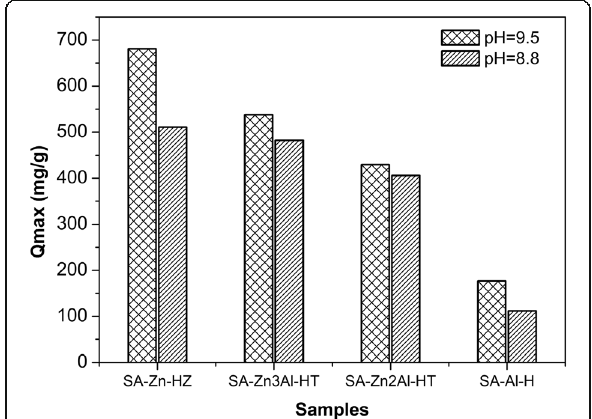
Fig. 1 The maximum adsorption capacities of SA-Zn-HZ, SA-Zn x Al-HT, and the control sample SA-Al-H with various Zn contents. From the left to the right, the Zn element contents decreased stepwise